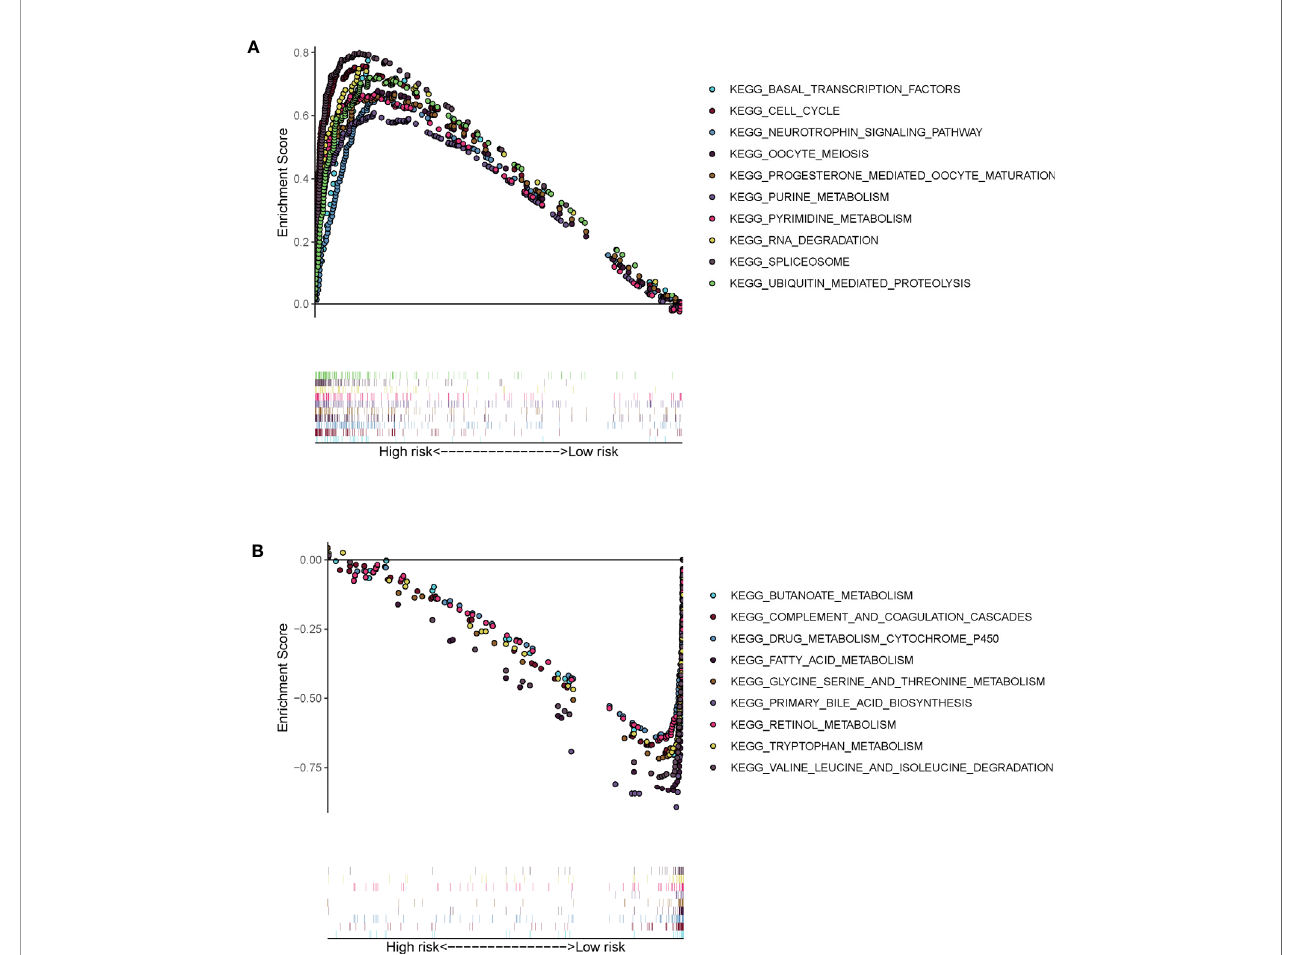
FIGURE 6 | Gene set enrichment analysis (KEGG pathways) in the TCGA cohort. (A) Enrichment pathways for high-risk patients. (B) Enrichment pathways for low- risk